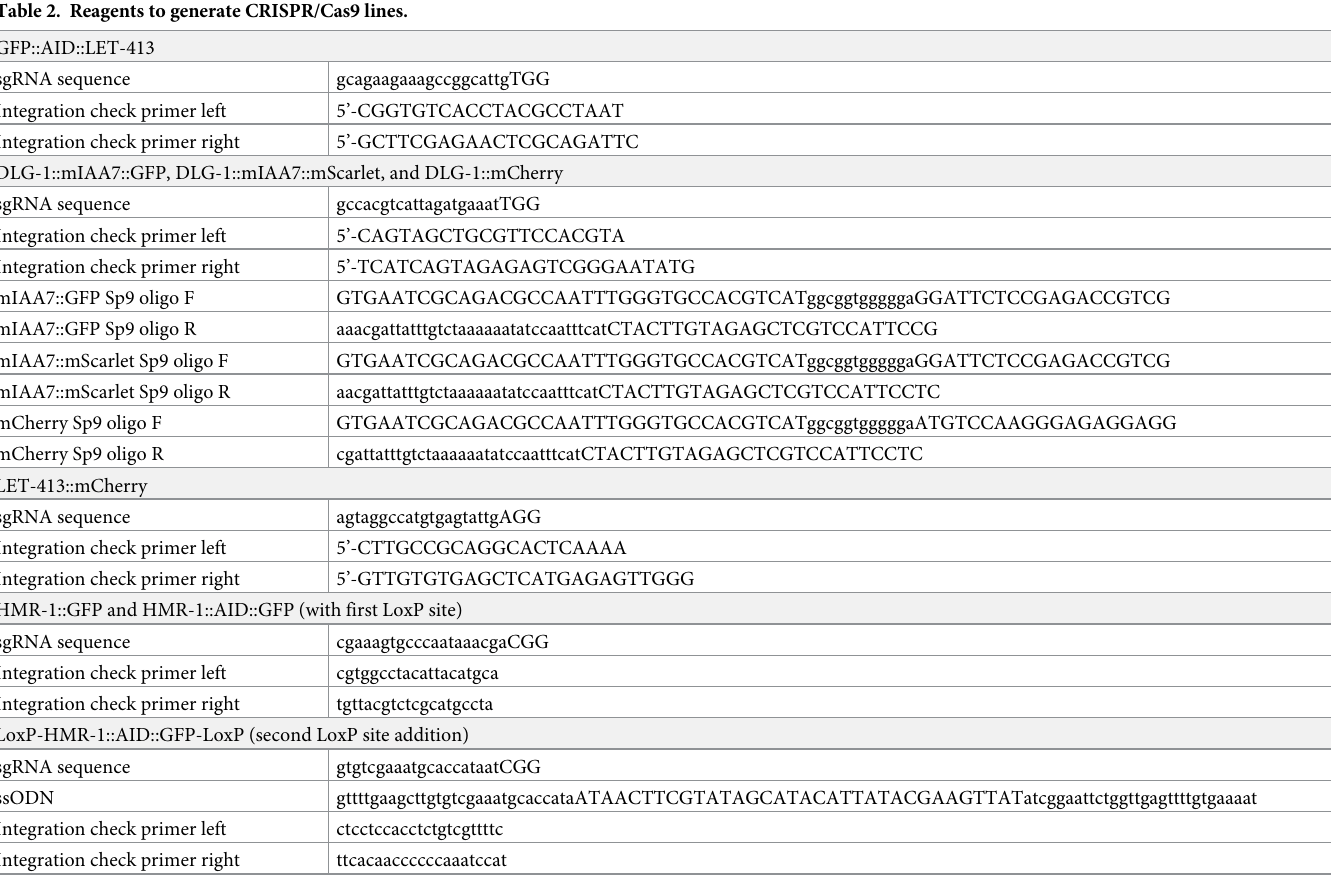
Table 2. Reagents to generate CRISPR/Cas9